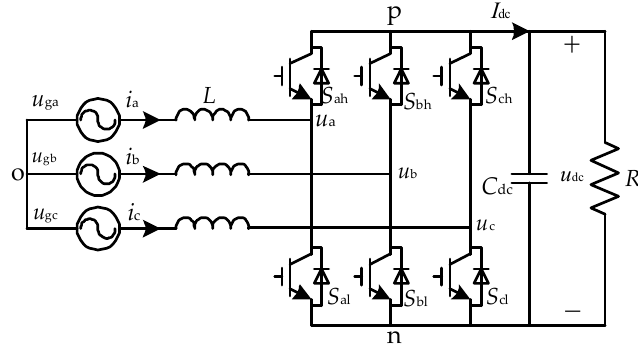
Figure 3. Structure of three-phase balanced PWM rectifier.